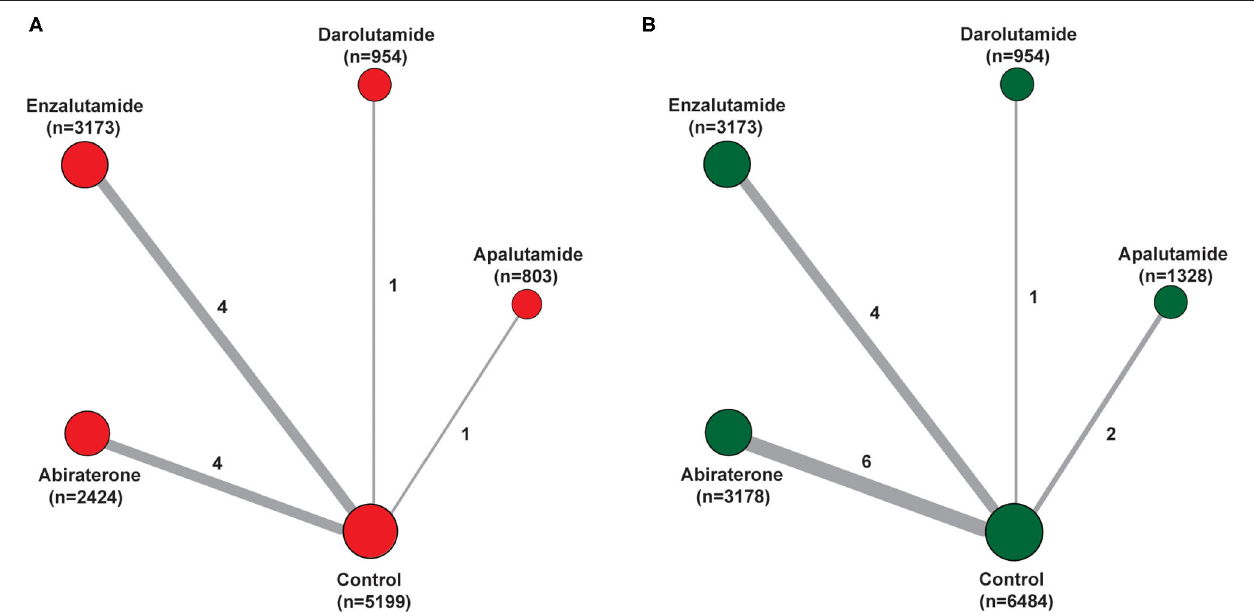
FIGURE 2 | Network of the comparisons for the Bayesian network meta-analysis. (A) Diarrhea; (B) constipation. The size of the nodes is proportional to the number of patients (in parentheses) randomized to receive the treatment. The width of the lines is proportional to the number of trials (beside the line) comparing the connected